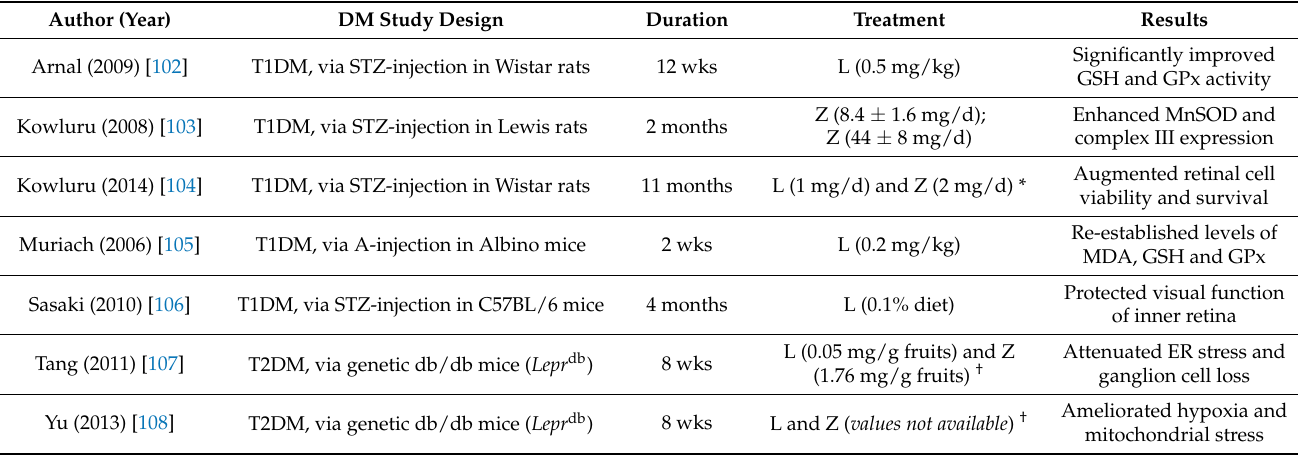
Table 2. Animal studies of carotenoid treatment in diabetic